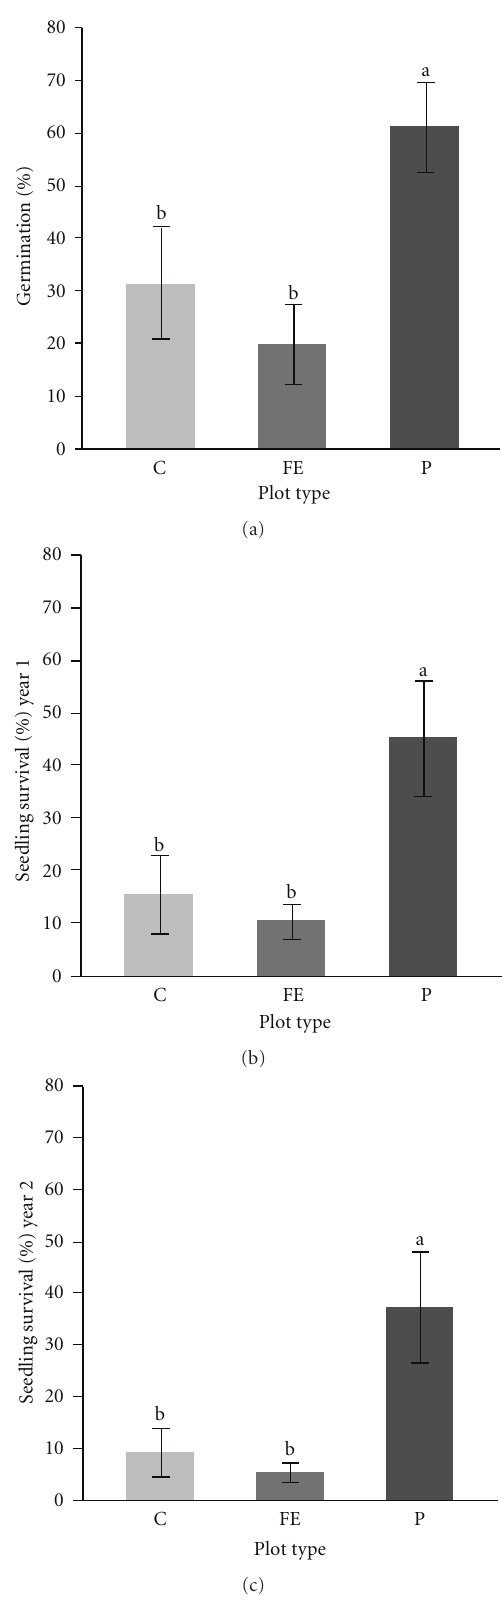
Figure 2: Germination and survival of the three habitat types: center (C), forest edge (FE), and pine plots (P). Pine plots had a significantly higher germination and survival rate after two growing seasons (all P < 0 . 001). Bars sharing common letters do not significantly di ff er at α = 0 . 05 determined by Tukey’s